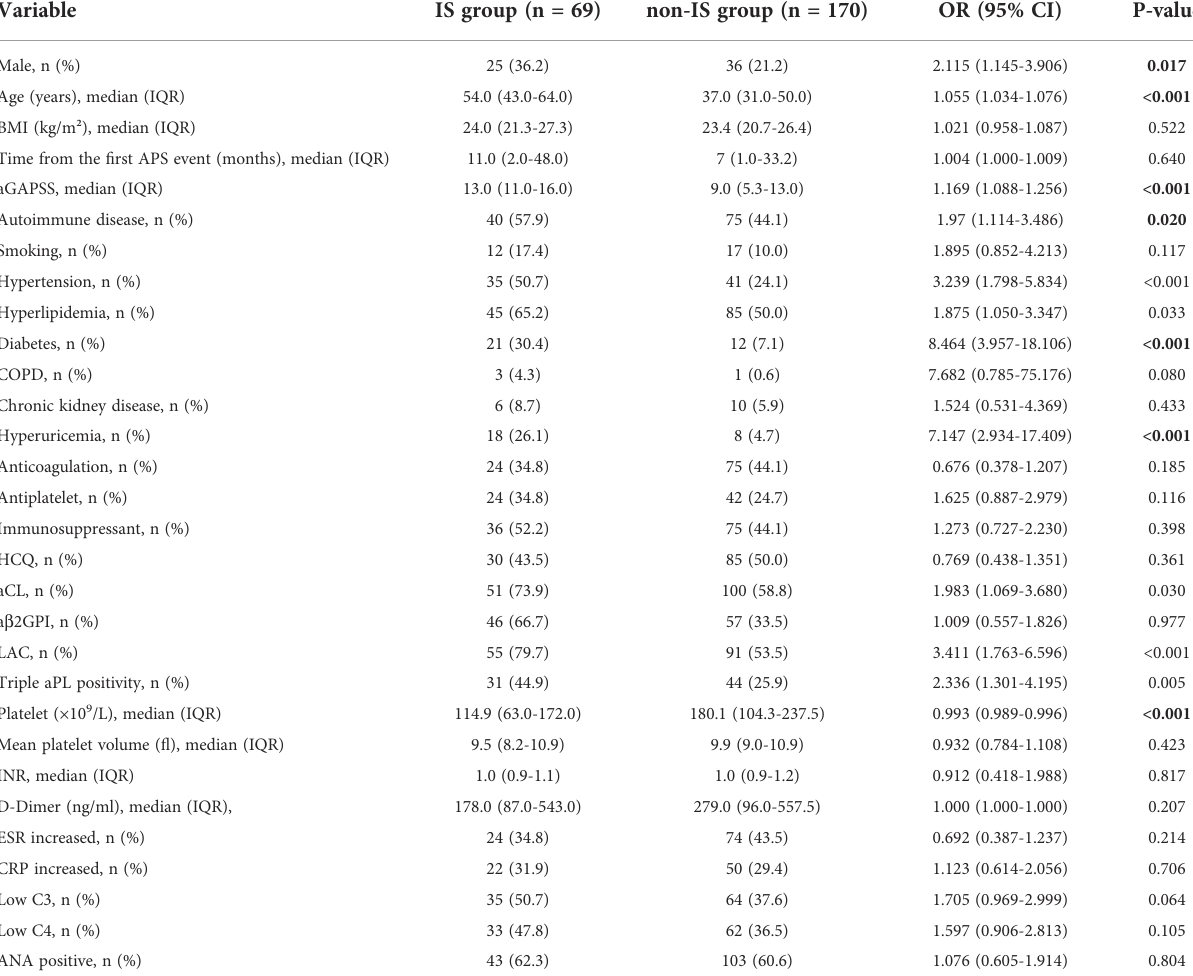
TABLE 2 Univariate analysis of ischemic stroke occurrence based on the training cohort.